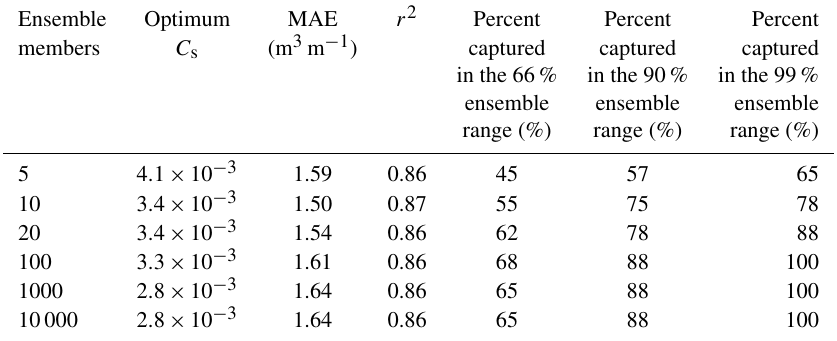
Table 1. Quantitative summary of Fig. 9, showing the optimum C s value for differing ensemble sizes, along with the associated mean absolute error (MAE) and percent of the 40 dune erosion observations captured by the 66%, 90%, and 99% ensemble prediction range. Ensemble Optimum MAE r 2 Percent Percent Percent members C s (m 3 m − 1 ) captured captured captured in the 66% in the 90% in the 99% ensemble ensemble ensemble range (%) range (%) range (%) 5 4 . 1 × 10 −